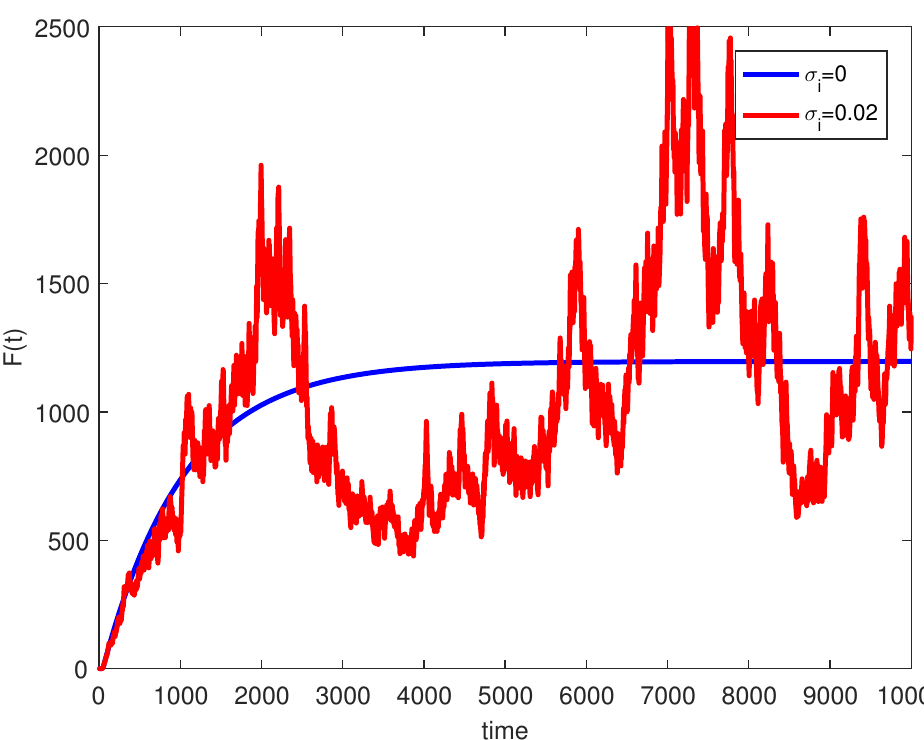
Figure 8. The stochastic RPW system (2) with σ i = 0 and σ i =